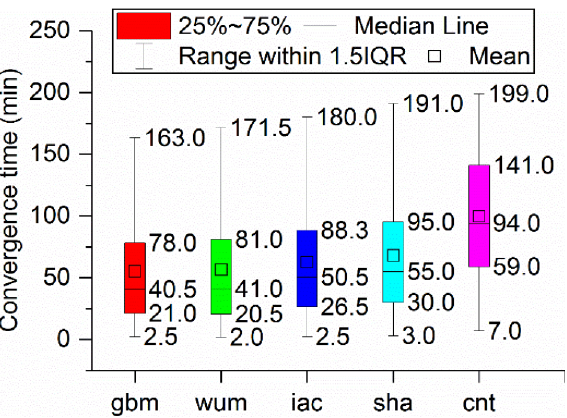
Figure 8. Boxplot of the convergence time of BDS-3 kinematic PPP with precise products from five ACs. In addition, the positioning accuracy derived from kinematic model was evaluated.